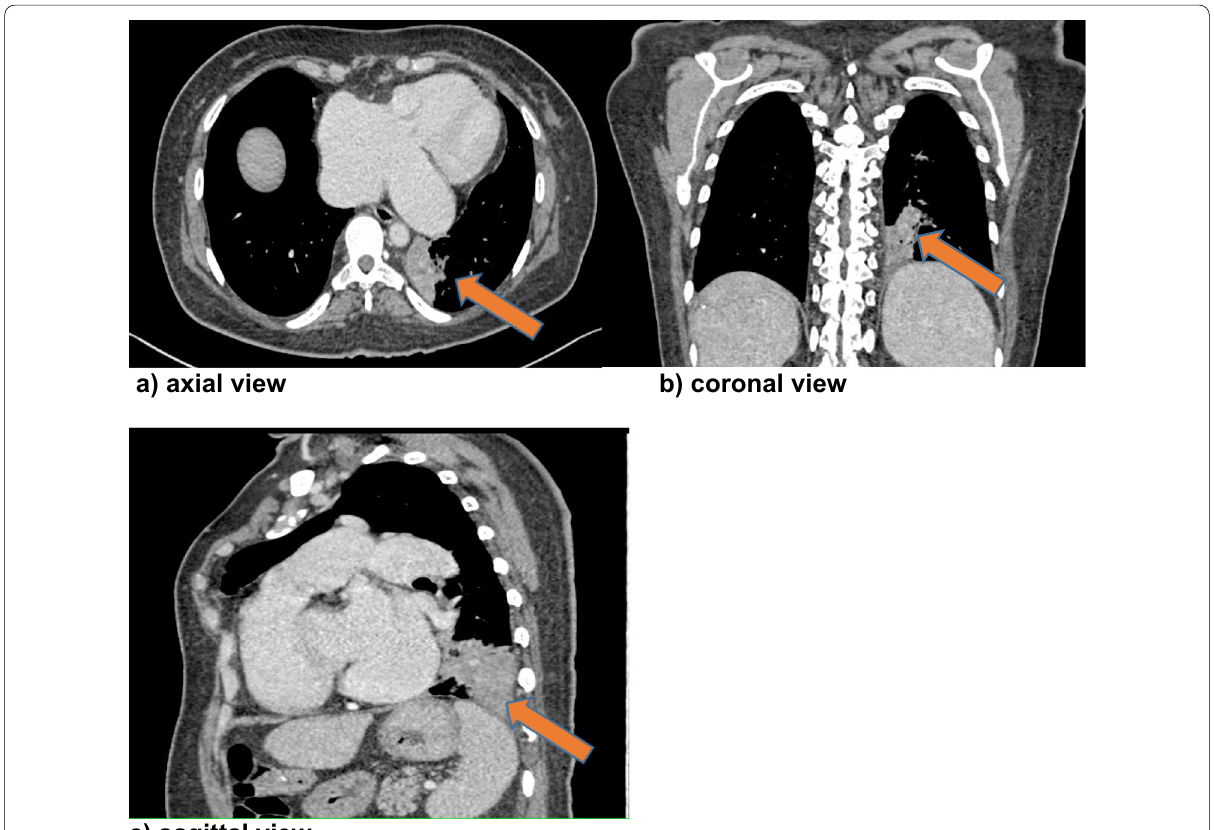
Fig. 1 CT thorax dated 2.12.14, a axial, b coronal and c sagittal views showing ill-defined heterogeneously enhancing mass at posterobasal segment of left lower